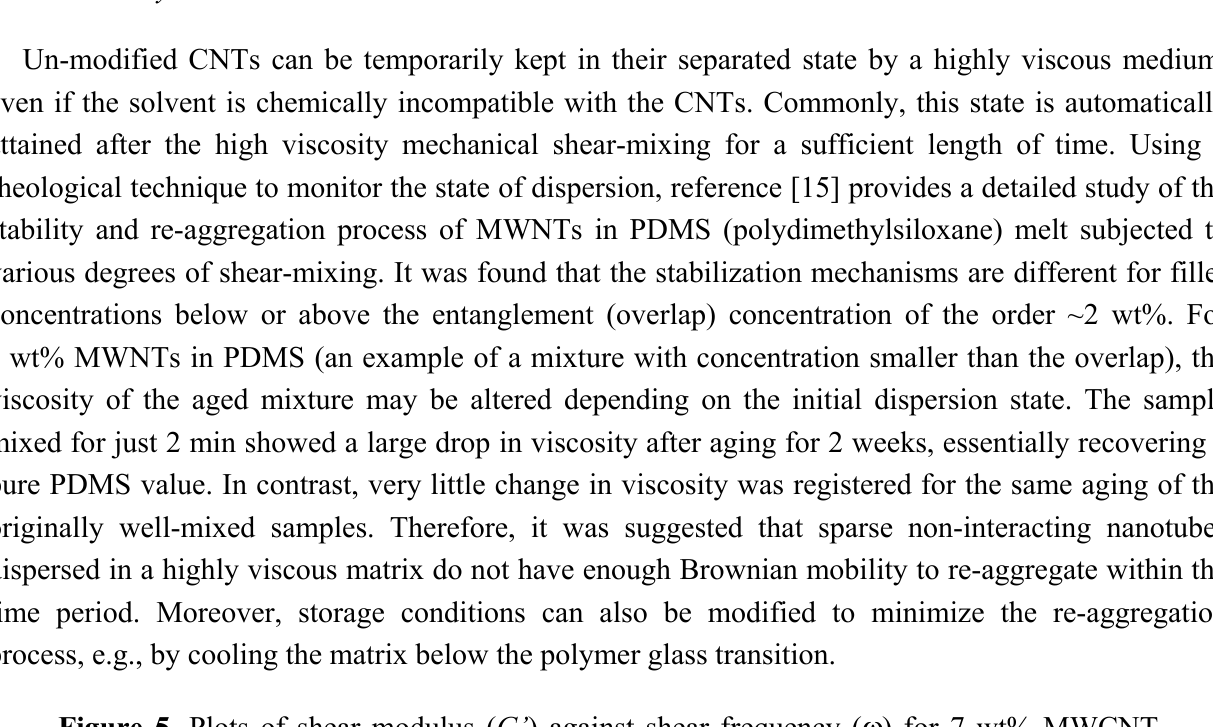
Figure 5. Plots of shear modulus ( G’ ) against shear frequency ( ω ) for 7 wt% MWCNT samples. Three groups of data are labeled: T1 for the short mixing time, T2 for the intermediate state of mixing, and T3 for the well-dispersed composite. The age of each sample is labeled in the